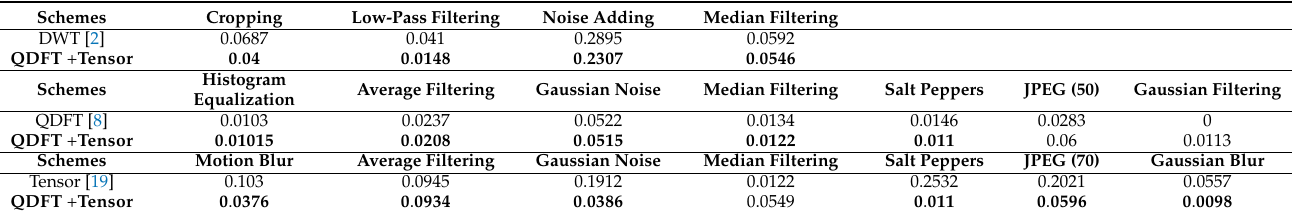
Table 3. BER under the image processing attacks and geometric attacks.